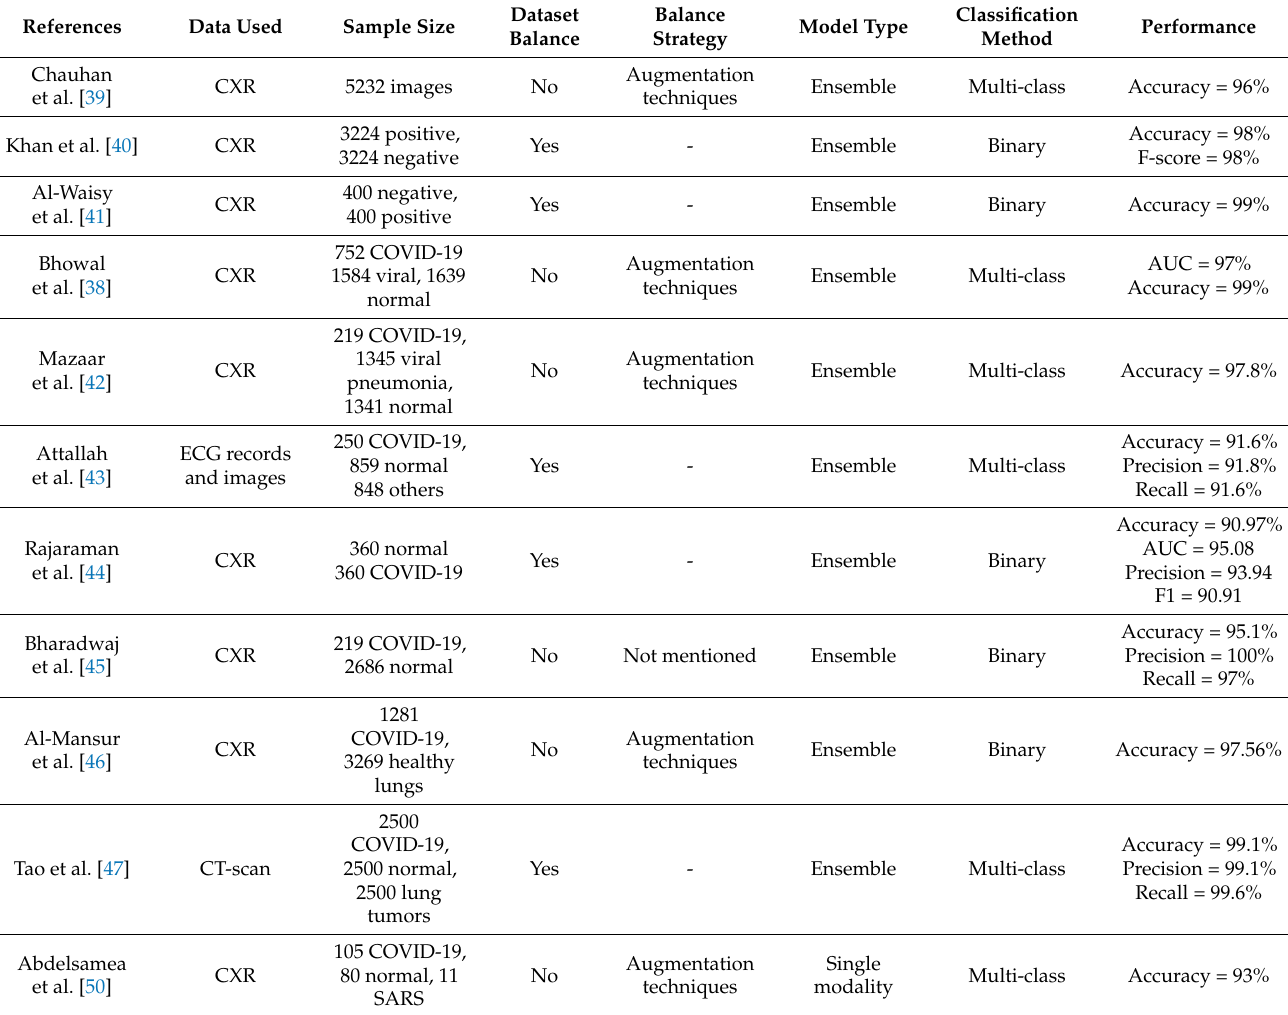
Table 1. Summary of the data extracted for each paper included in our